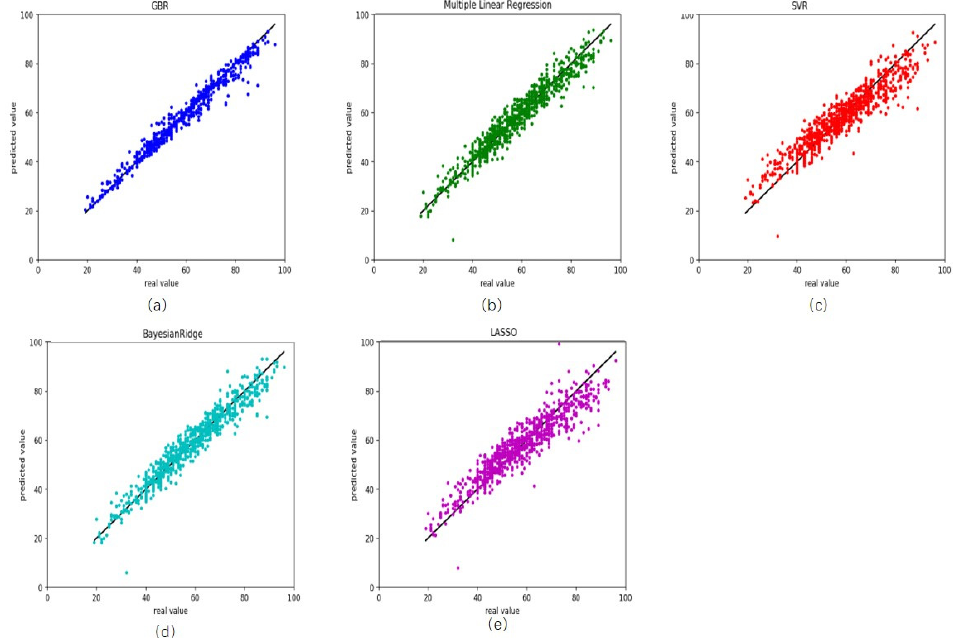
Figure 1. Comparison results between the actual age and predicted age by five different models on the training health data. ( a ) gradient boosting regression, ( b ) multiple linear regression, ( c ) support vector regression, ( d ) Bayesian ridge regression and ( e ) lasso regression. Table 2. Comparison results of our predictor with other four regression models and Horvath’s model on healthy